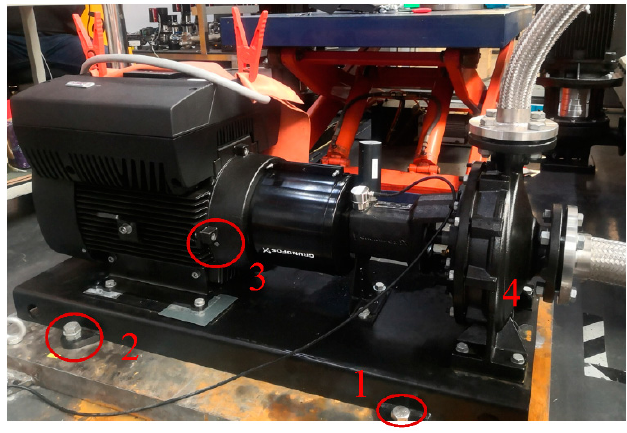
Figure 9. Four corner screws in the pump. 1, 2, 3 and 4 represent the screws on the four corners of the pump foundation.